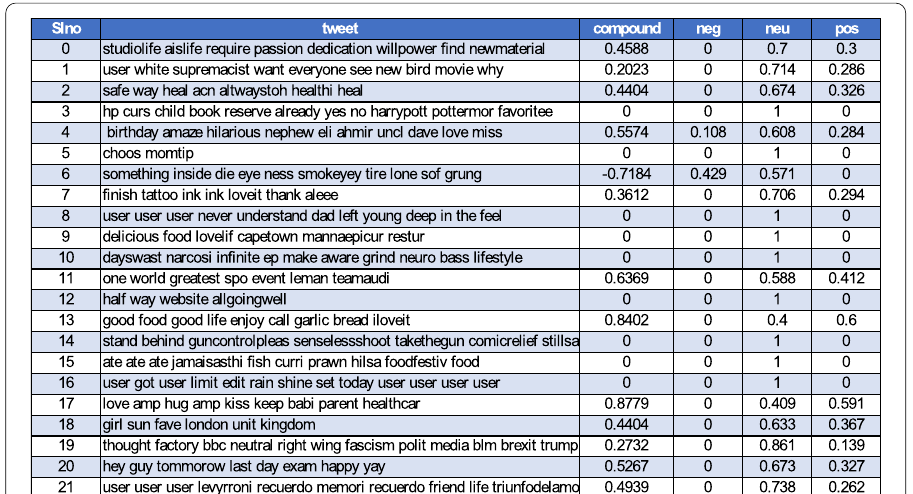
Fig. 19 Output Excel file after Binary Sentiment Analysis using Vader Algorithm